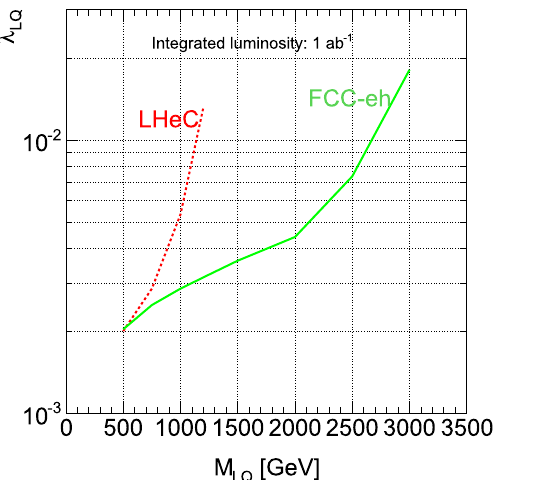
Fig. 15.8 The pair production cross section for colour octets of various spins